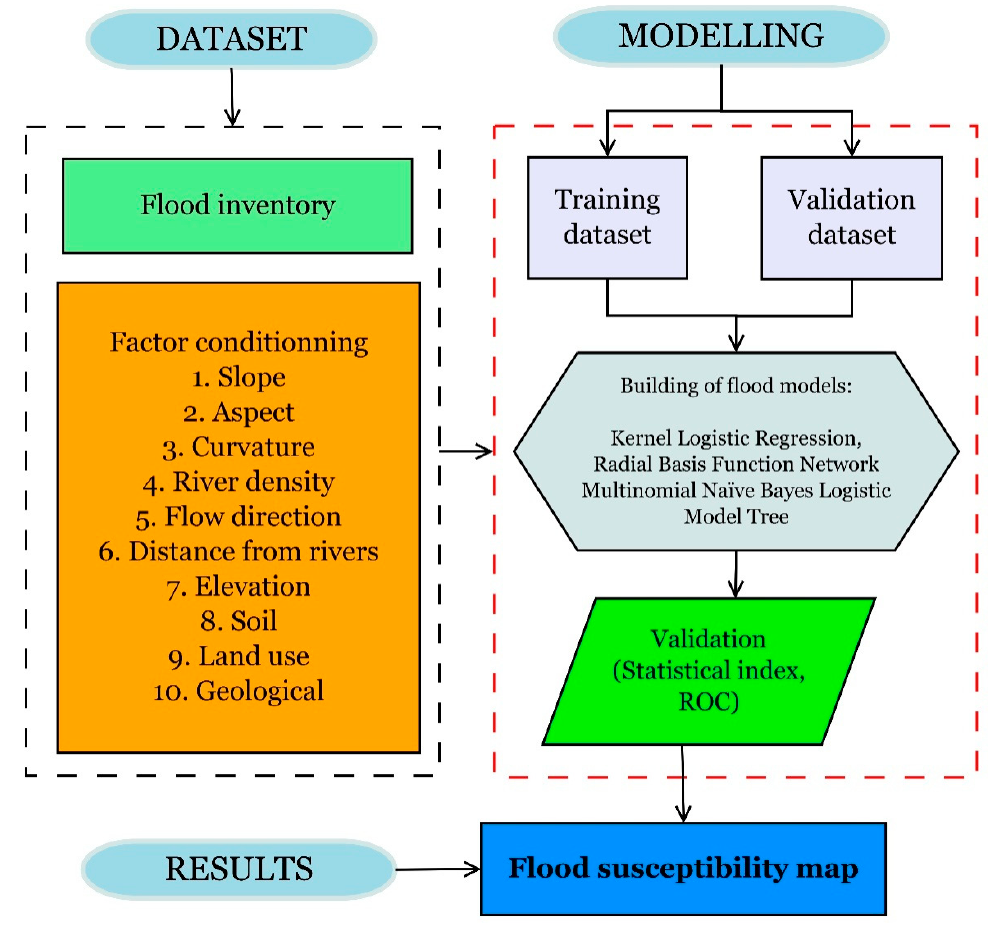
Figure 3. Methodological flow chart of this study.